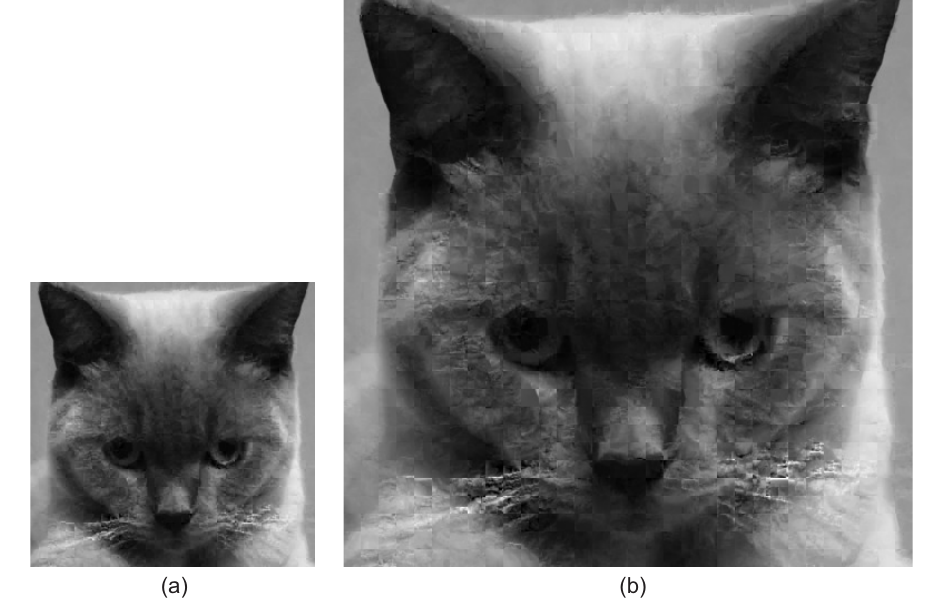
Figure 7. Fractal zoom-in Cat image in ( a ) the same size as that of original image (i.e., 256 × 256) and ( b ) an enlargement to the size of 512 × 512, with both images decoded with identical range block size of 8 × 8, zero image as initial image, and the number of iterations of 20 (PSNR = 25.2695 dB, SSIM =